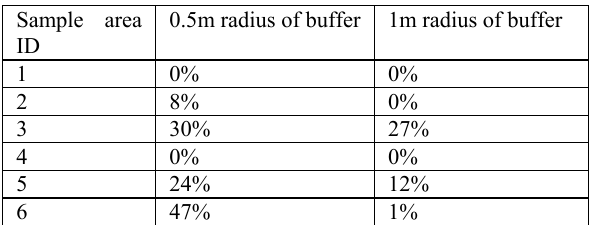
Table 1. Deviation rate of each shoulder line with 0.5m and 1m buffer radius